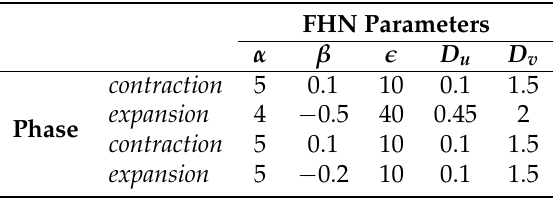
Table 1. Set of values for the FitzHugh–Nagumo (FHN) model, in order to reproduce the specific behaviors in each of the four stages of the Reaction Diffusion (RD)-based